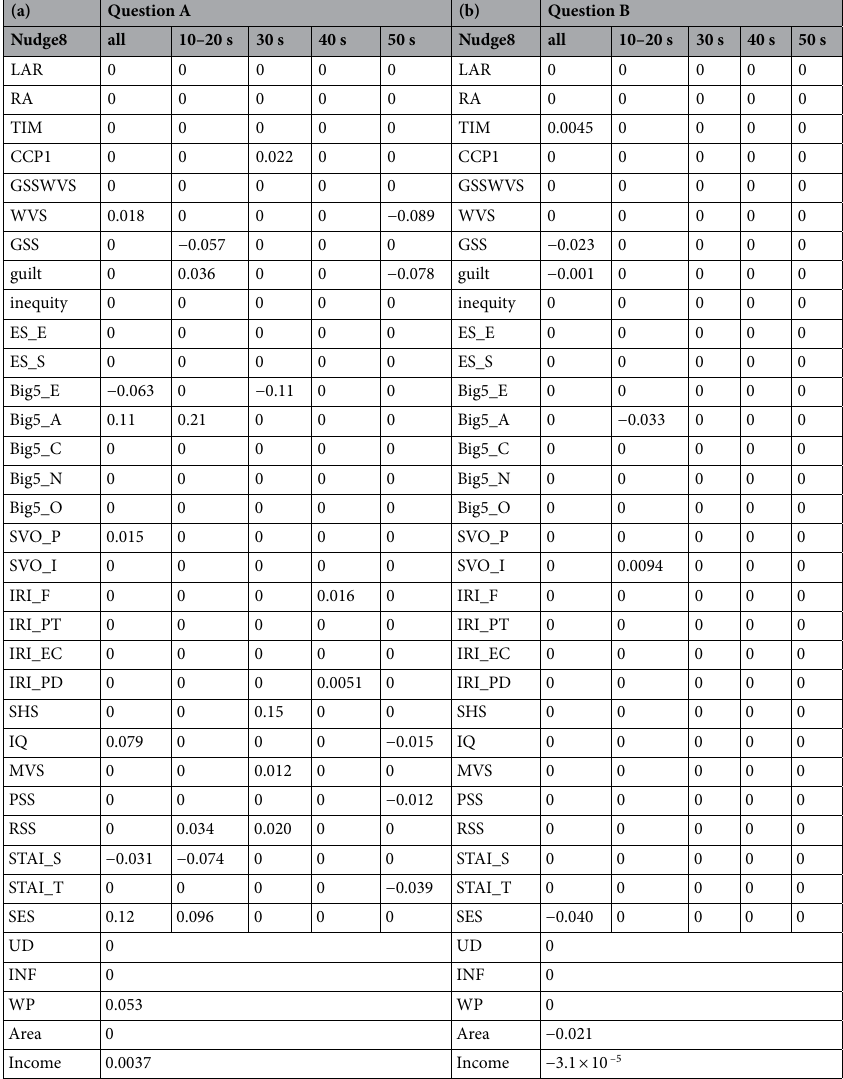
Table 4. LASSO regression of the willingness and refusal to be vaccinated by social personality trait scores and their interactions with age in participants who only received nudge 8. UD, underlying disease; INF, infected close relative; WP, workplace; area, place of residence; income, annual